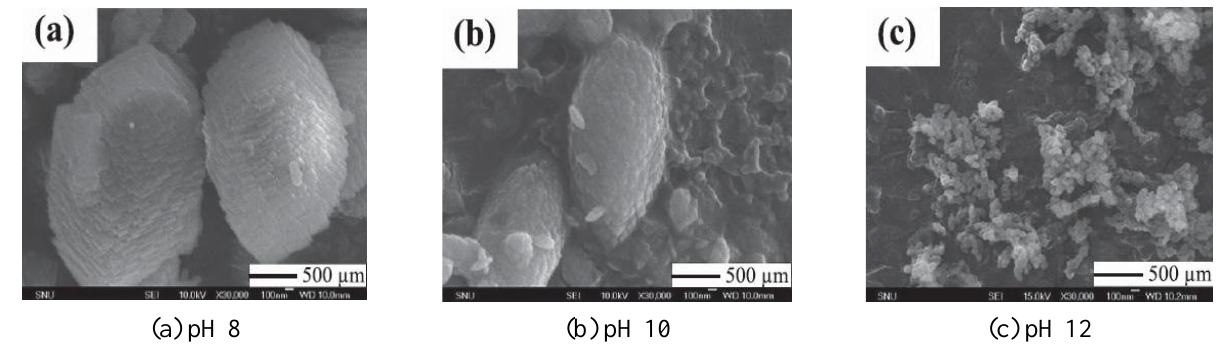
Figure 16. Scanning electron microscope (SEM) images of CaCO pHs with the addition of NH Resources Processing ).